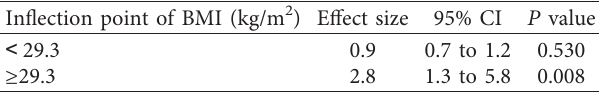
Table 4: The results of BMI and readmission of AMI using two- piecewise linear